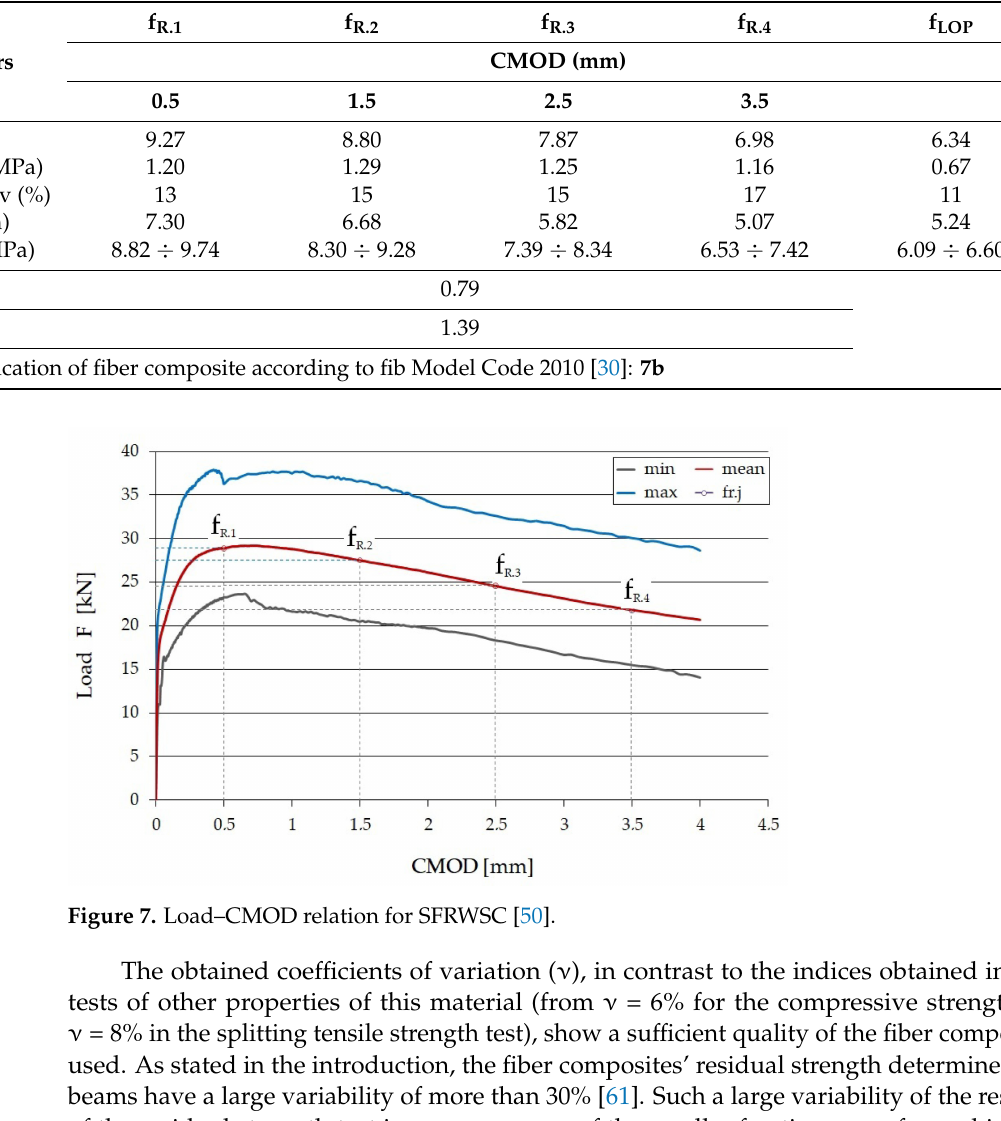
Table 1. Results of the flexural tests.